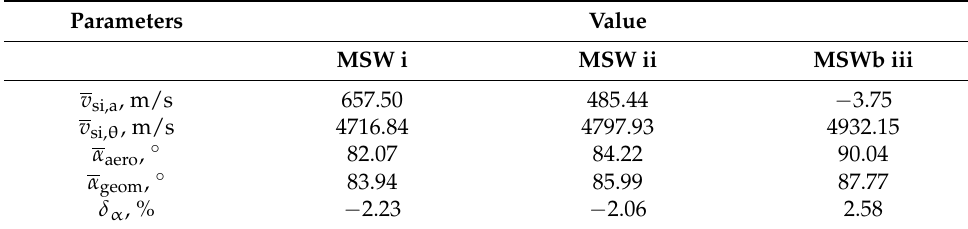
Table 4. Integral average results of the